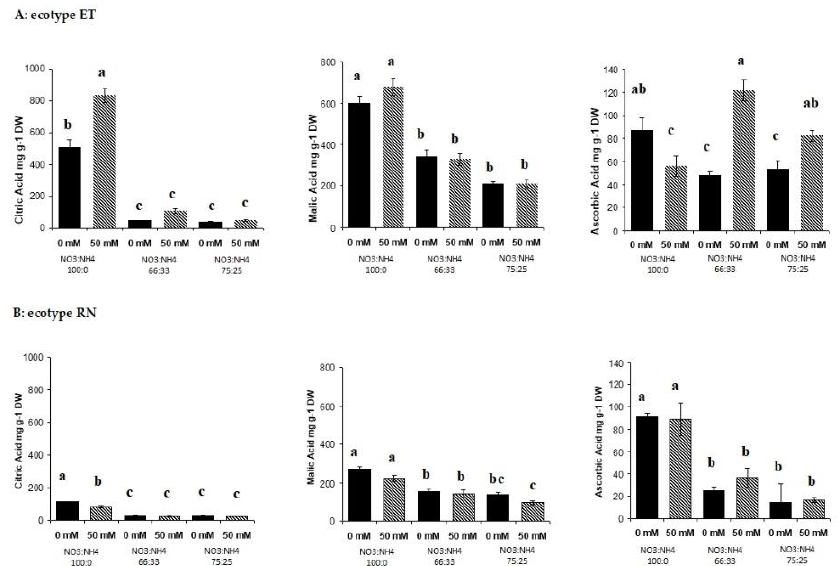
Figure 5. Effect of the nitrate to ammonium ratio (100:00, 66:33, 25:75) and salinity (0, 50 mM) on the organic acid accumulation of P. oleracea leaves ecotypes ET (A) and RN (B). The values are means ± SE ( n = 6). Bars with different letters are significantly different between treatments, P ≤ 0.05, as determined by Tukey–Kramer HSD.